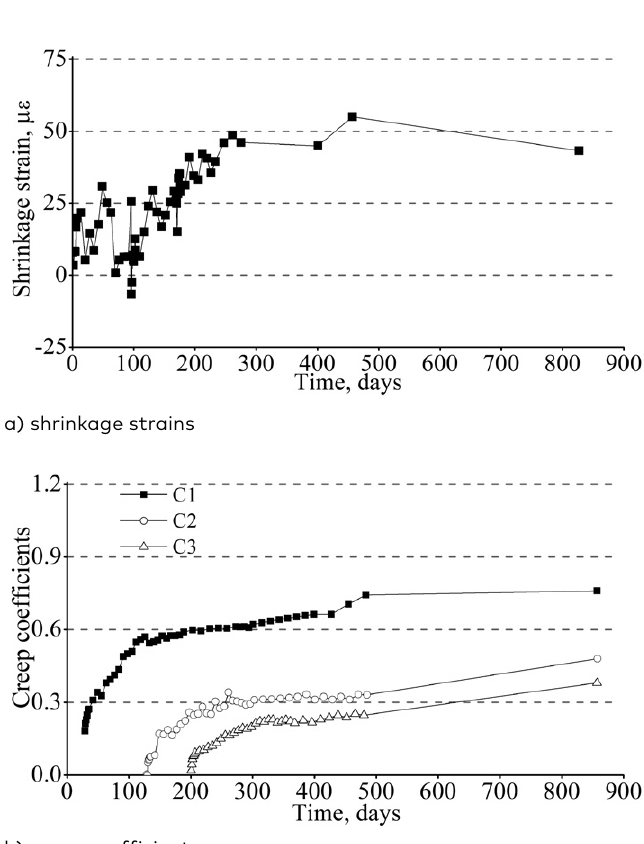
Figure 7. Shrinkage strains and creep coefficients versus age for C80